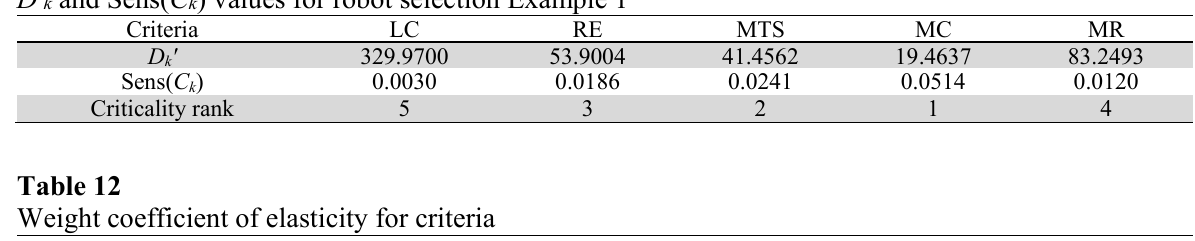
Weight coefficient of elasticity for criteria Criteria